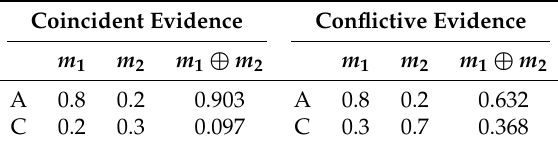
Table 1. Examples for combination